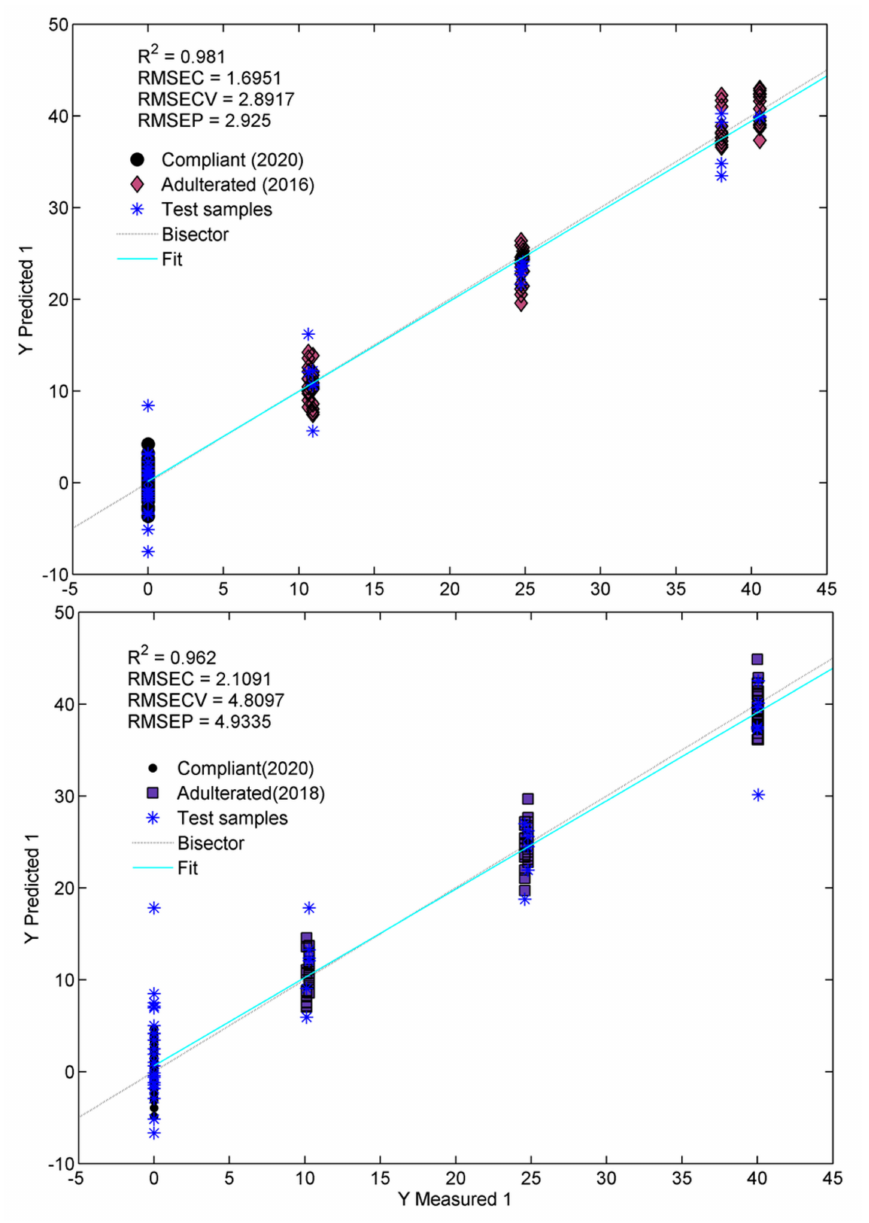
Figure 6. Plot of measured against predicted responses (% of adulteration) and related figure of